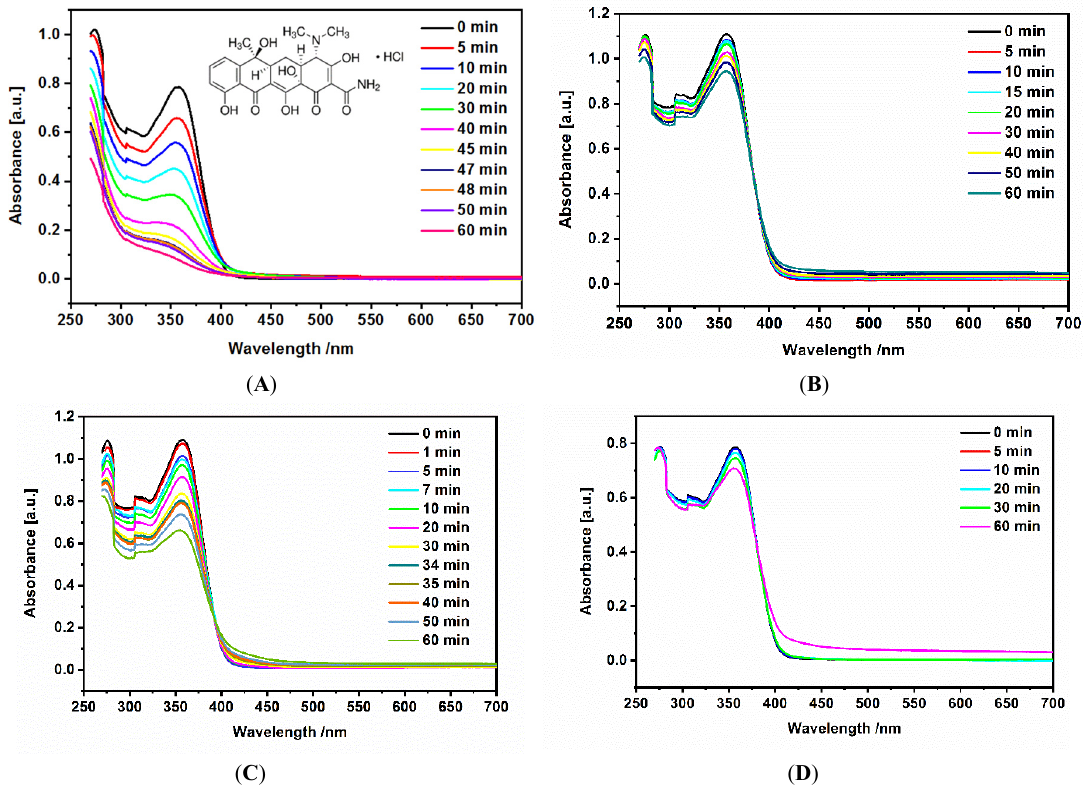
Figure 9. Absorption spectra of tetracycline (TC) ( A ) and ( C ) in the presence and ( B ) and ( D ) in the absence of CdS nanoparticle suspension, recorded during the irradiation with mercury quartz lamp; ( A ) and ( B ) without, while ( C ) and ( D ) with a UV filter, respectively.